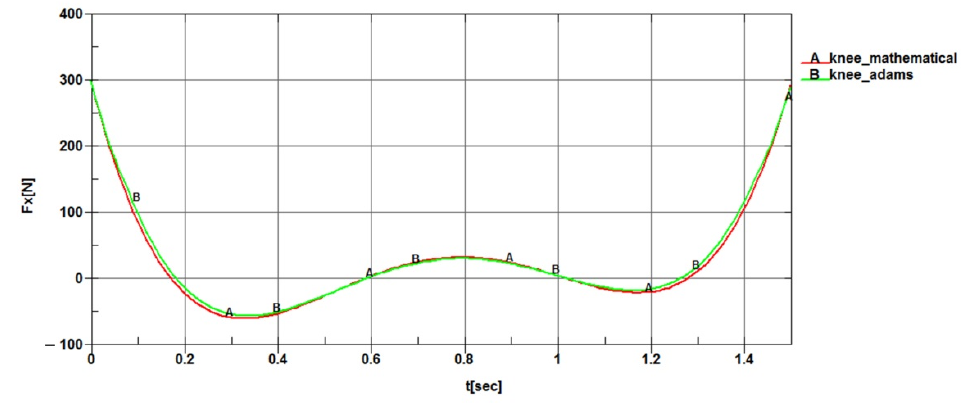
Figure 15. Connection forces component on x-axis for knee joint vs. time (with ground contact).